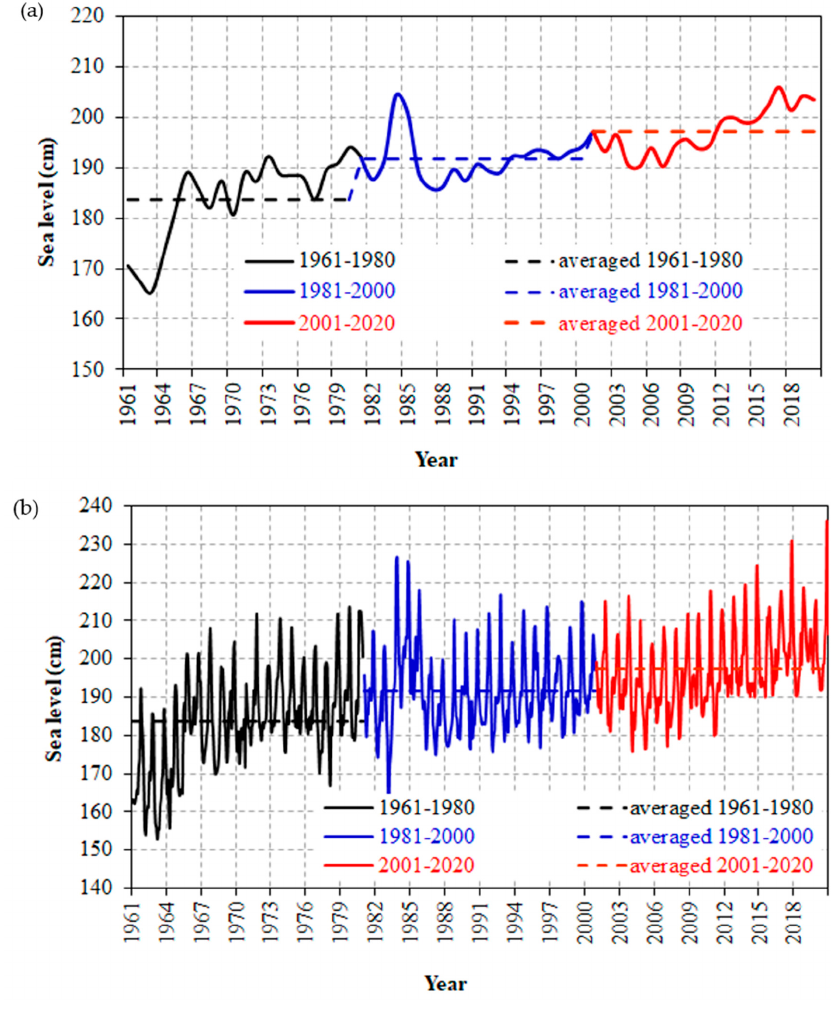
Figure 3. Average annual ( a ) and monthly ( b ) sea level at the Hon Dau station (1961–2020).